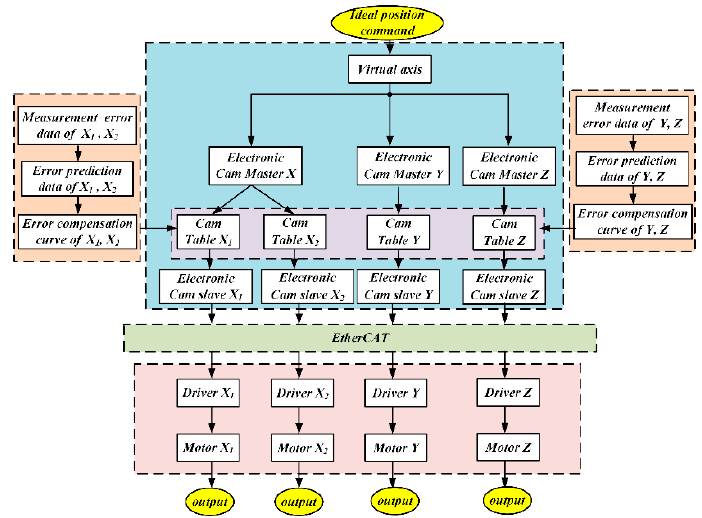
Figure 13. Schematic diagram of virtual axis-electronic cam error compensation method.